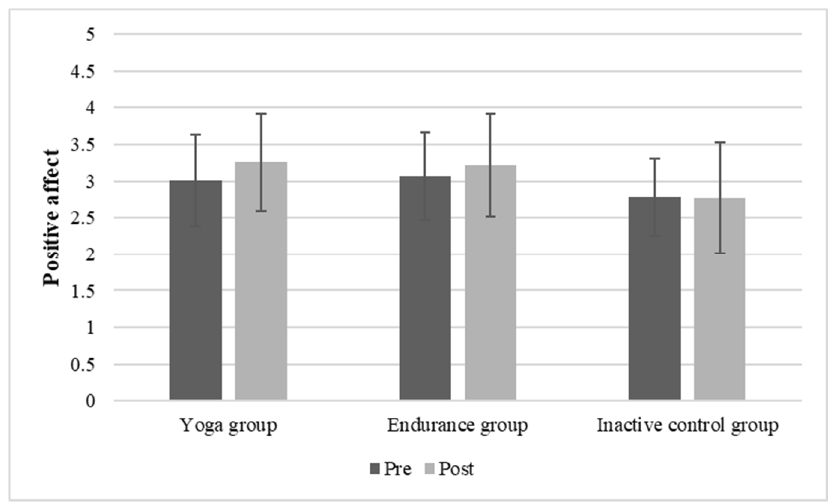
Figure 2. Mean (SD) positive affect before and after 20-min of yoga, endurance, or non-activity.